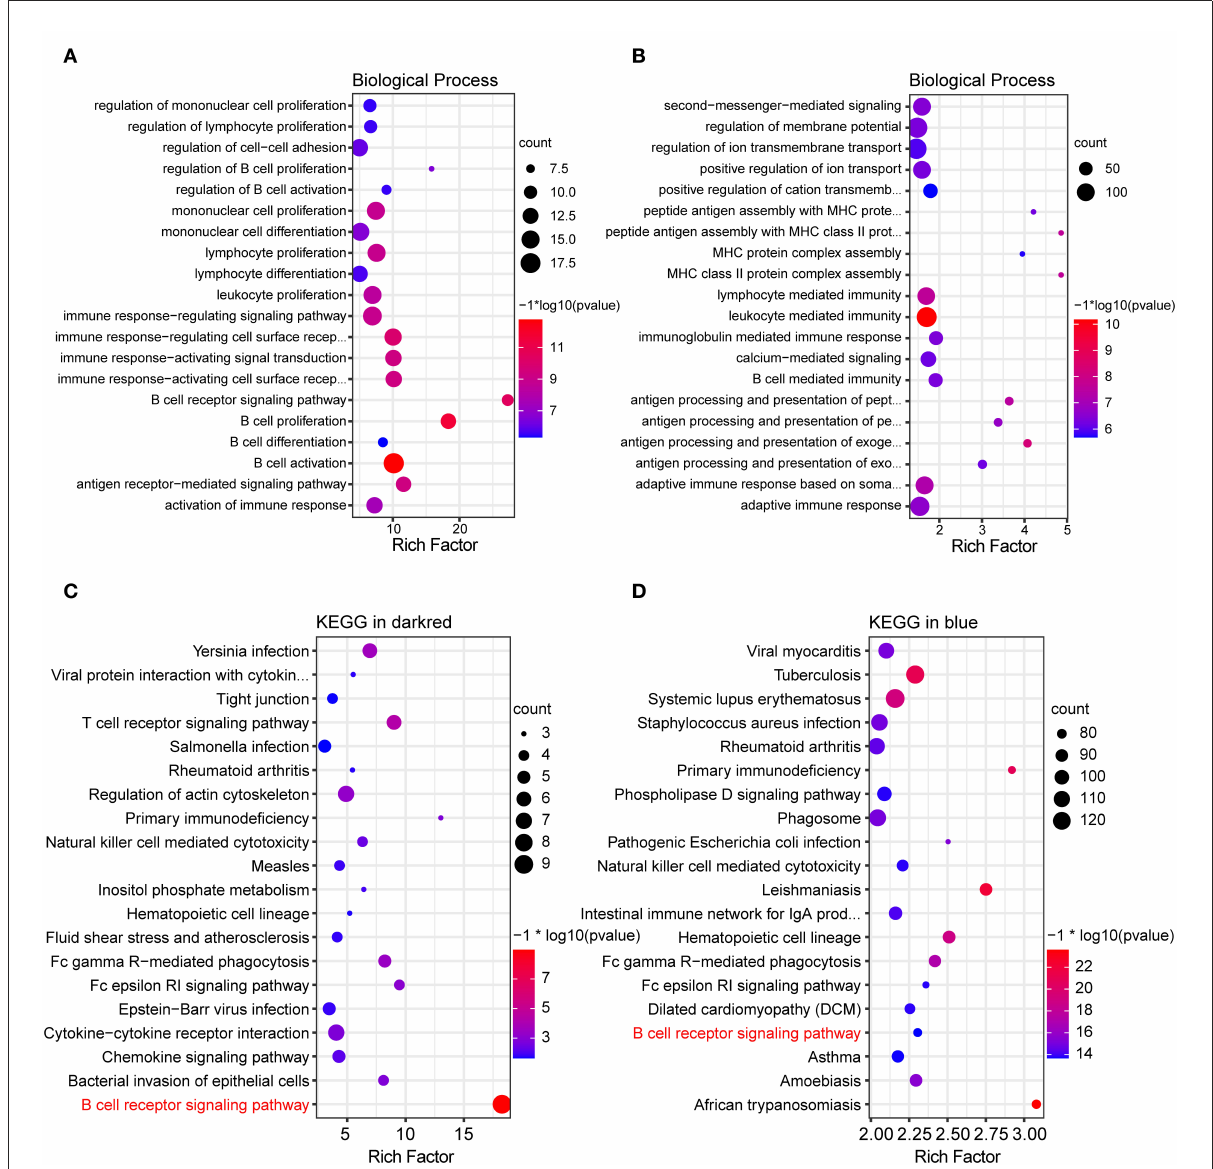
FIGURE3 GO and KEGG functional enrichment analysis of key modules. (A,B) Bubble plot showing top 20 terms of biological process in the dark red and blue module, respectively. (C,D) Bubble plot showing top 20 pathways of KEGG functional enrichment analysis in the dark red and blue module,